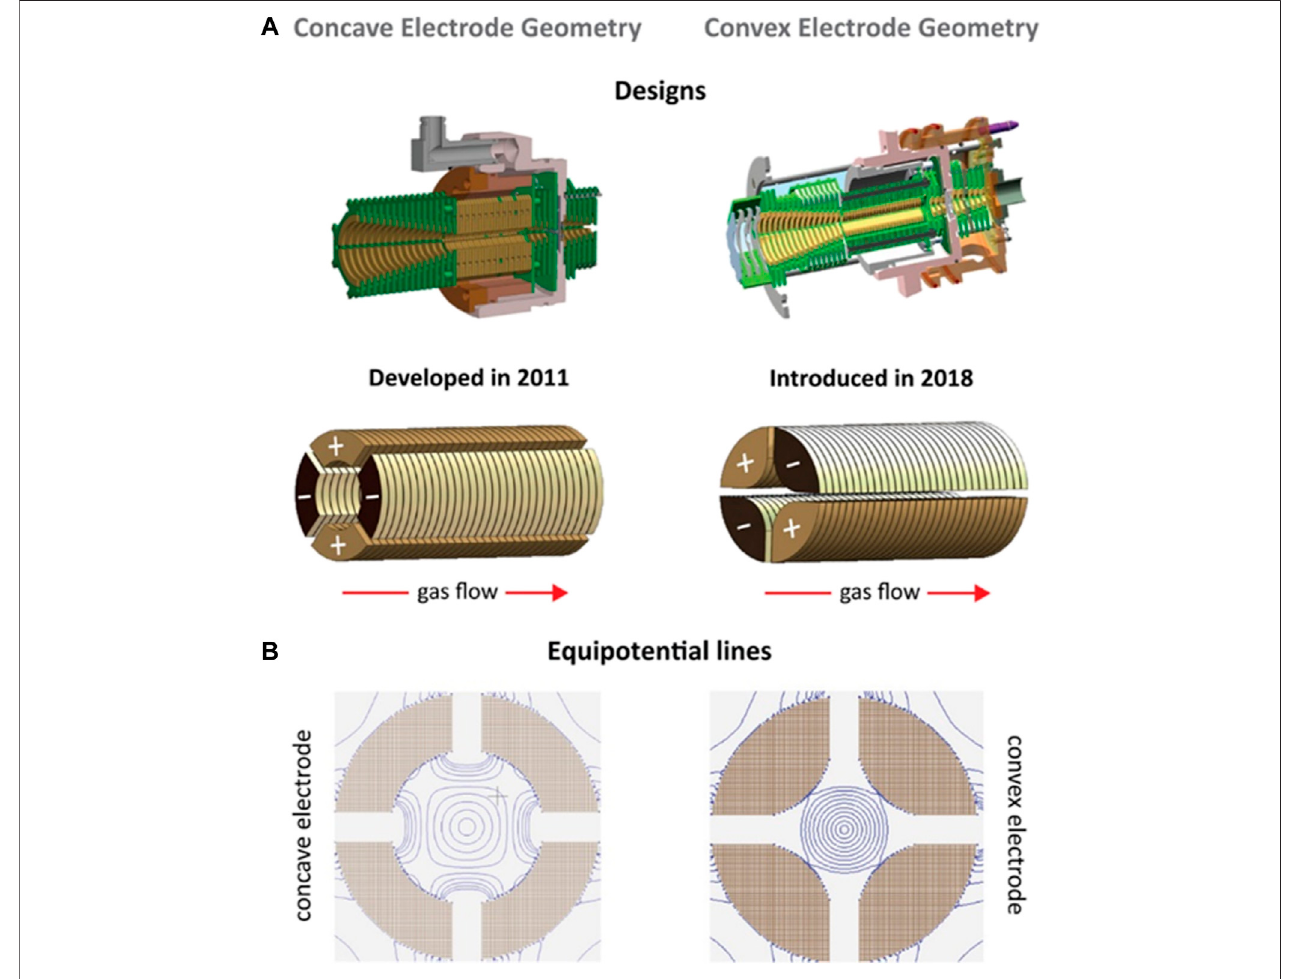
FIGURE 2 | Designs and simulations of TIMS. (A) Designs of the concave and convex electrode geometries; (B) Equipotential lines of the concave and convex electrodegeometriesatagivenappliedvoltage.Adapted withpermissionfromJeanneDitFouque,K.,Garabedian,A.,Leng,F.,Tse-Dinh,Y.-C., Ridgeway,M.E.,Park, M. A., et al. (2021). Anal. Chem. 93, 2,933 – 2,941 (Fouque et al., 2021). Copyright 2021 American Chemical Society.